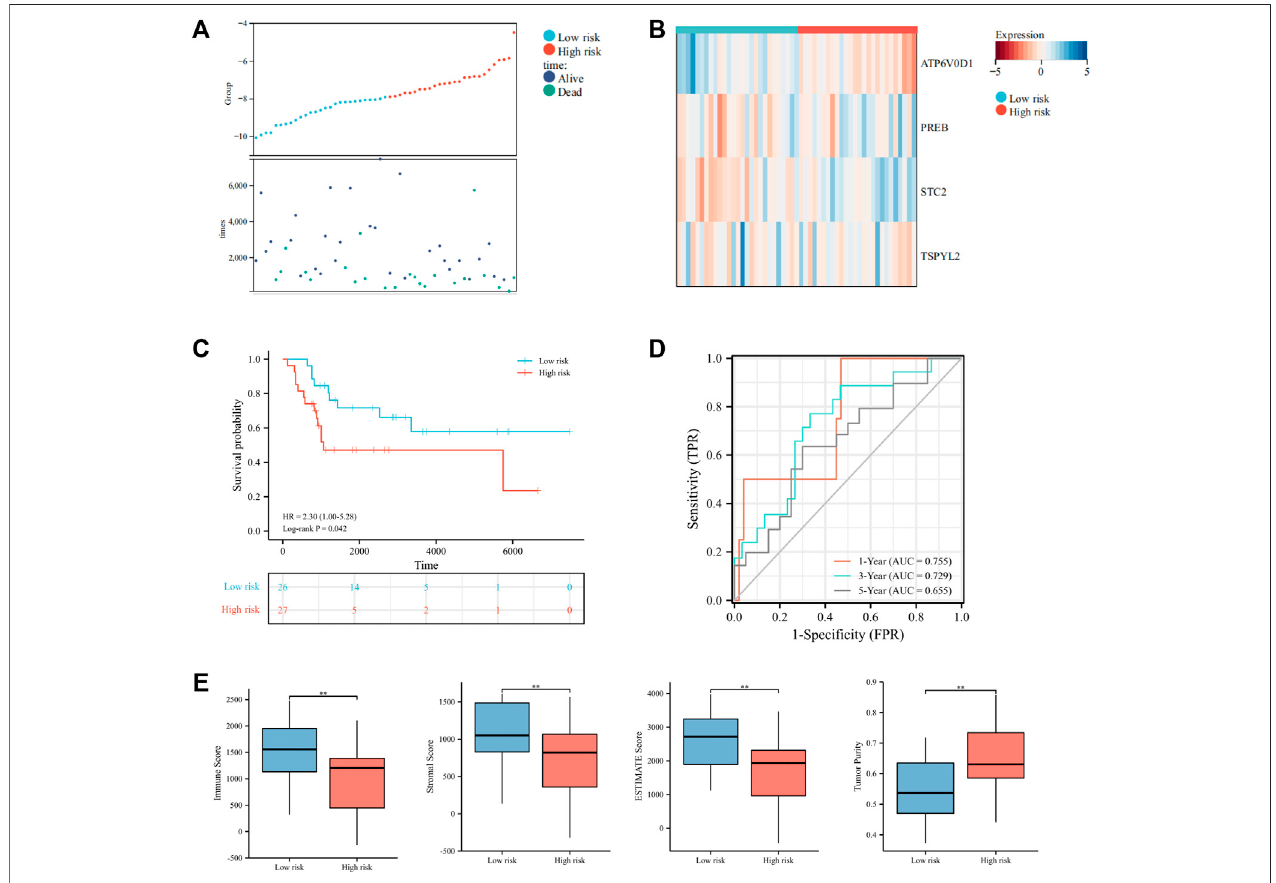
FIGURE 6 | Validation of the constructed risk signature in the veri fi cation cohort. (A) Distribution of risk scores and patient status in different risk groups. (B) Heat map displayed the expressions of four candidate genes in the veri fi cation cohort. (C) Survival curves of the two risk groups. (D) Time-dependent ROC curve in the veri fi cation cohort. (E) Tumor microenvironment analysis by the ESTIMATE algorithm. * p < 0.05; ** p < 0.01; *** p < 0.001.